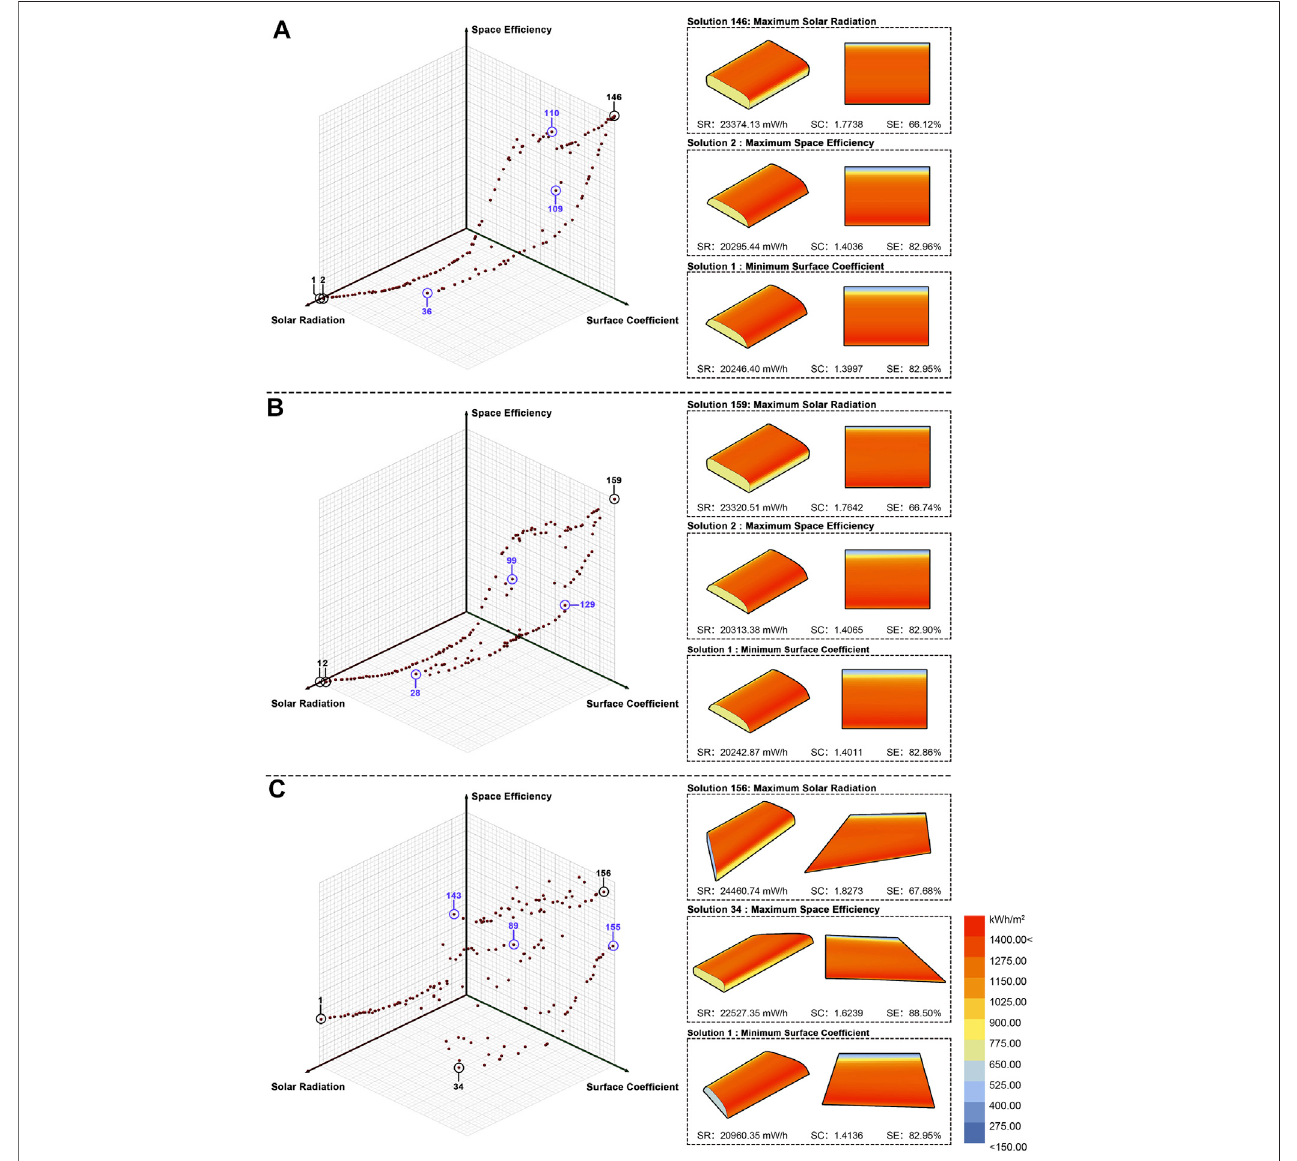
FIGURE 12 | Pareto Frontier of S1 and the building shapes of its optimal solutions: (A) S4; (B) S5; (C) S6.